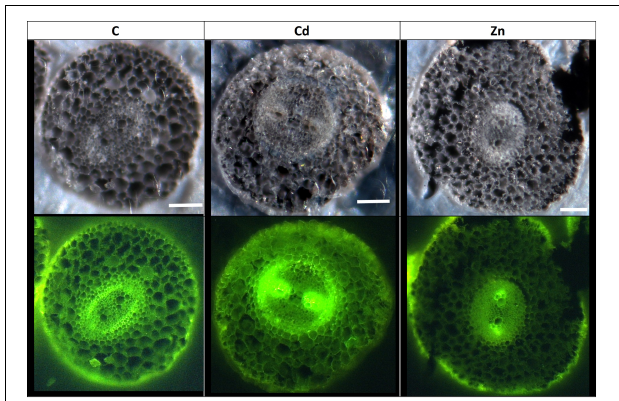
FIGURE 6 | Confocal microscope observation of hemp root sections (60 µ m) (Axioscope 2 MOT, 405 nm). Plants were exposed for 1 week to Cd (20 µ M) or Zn (100 µ M) (C: control plants not exposed to HM). Fluorescence highlights lignified areas (yellow). Scale bar: 100 µ